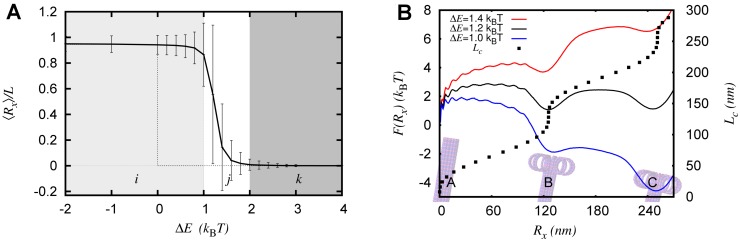
Role of thermal fluctuations.(A) ⟨R
x⟩ vs ΔE with (solid), and without (dotted), thermal fluctuations. Shaded regions correspond to peeled off (i), bounded (k), and transition/mixed (j) states of microtubule. The vertical bars represent standard deviation, and imply coexistence of diverse set of conformations in j. (B) The free energy F(R
x) when ΔE = 1.0, 1.2, 1.4k
B
T (bottom to top, continuous curves). R
x vs L
c relation (Eq. 7) is plotted along the right hand side ordinate (Y
2 axis). Microtubule pictures are embedded in the background to indicate that at R
x = 0 we have a tubular MT; at R
x ≈ 120nm we have a partially peeled off MT with the unzippered PF forming a circle-like conformation; at R
x ≈ 240nm we have a partially peeled off MT with the unzippered PF forming a conformation close to two full circles. Each of these states correspond to local minima in the free energy. These results are obtained by employing umbrella sampling method.